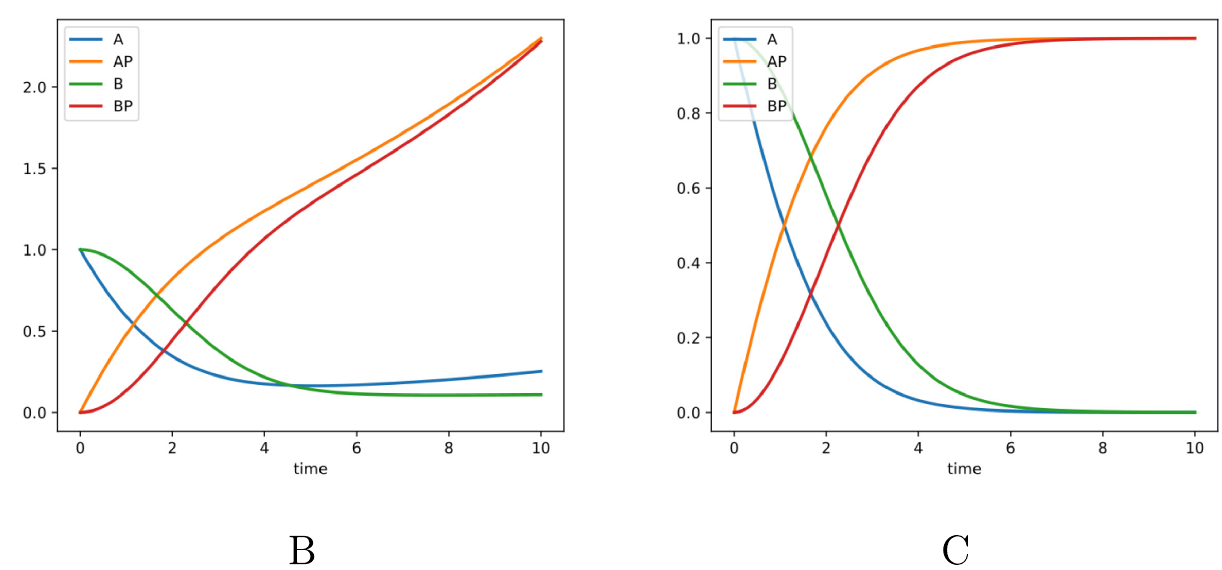
Fig 1. Demonstration of the divergence problem. In the phosphorylation cascade in (A), the quantities A + A P and B + B P should be constant in time. However, letting k 0 ¼ k þ a and k 0 ¼ k (cid:0) a results in the loss of this conservation relationship, as shown by the value of A P in the numerical fA rA fA rA integration of this ODE system (B), which exceeds the total starting amount of A + A P = 1. This phenomenon also applies to networks that do not have conserved quantities, as any steady–state value will tend to drift over time. Using the total quantity representation of Eq (2), this problem can be eliminated